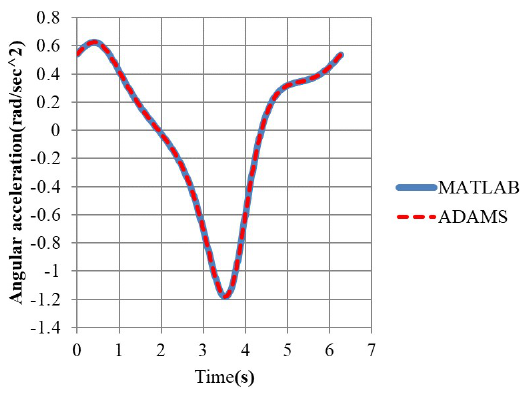
Figure 13. Comparison of our modeling computation with that of ADAMS on α 6 . Figure 13. C omparison of our modeling computation with that of ADAMS on 6  .